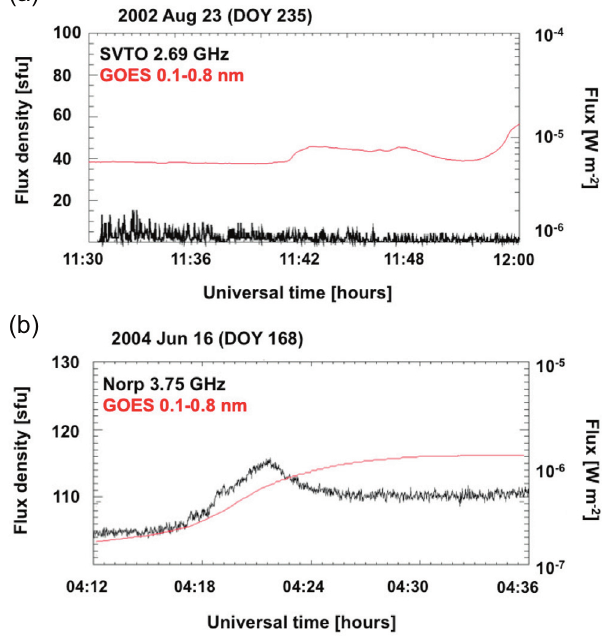
Fig. 1. Flux density profiles of discarded events. (a) No microwave emissions associated with the SXR burst. (b) Thermal microwave emissions.